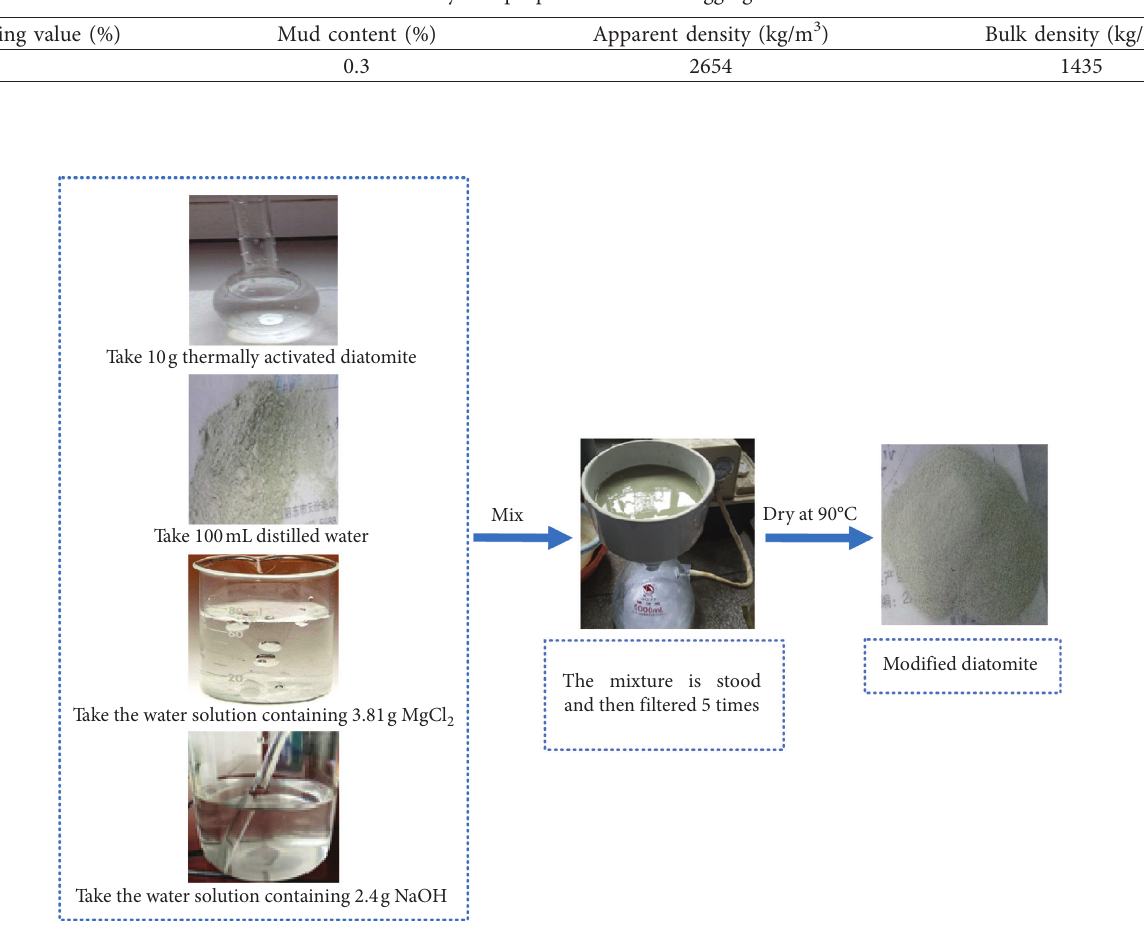
Figure 1: Chart of diatomite